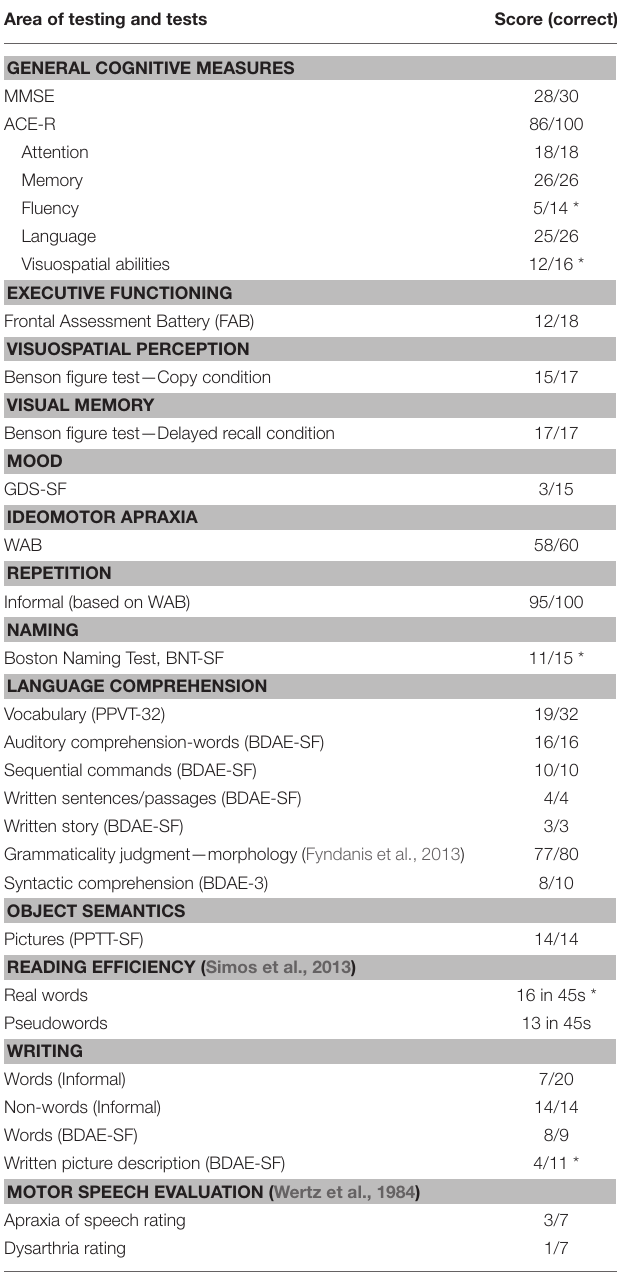
TABLE 3 | Background neuropsychological assessment